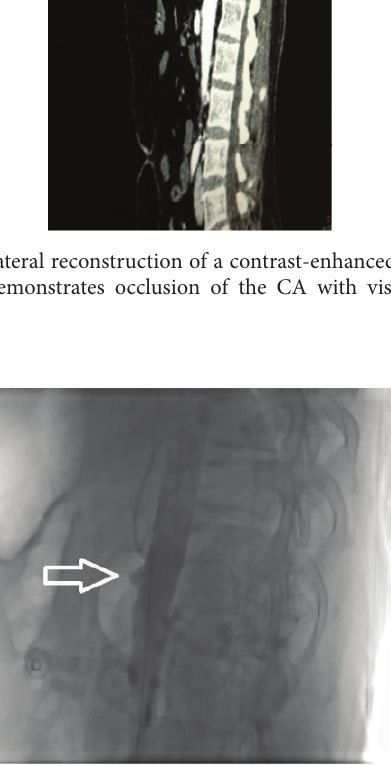
Figure 2: Angiography in a lateral view showing the stump of the CA (arrow).